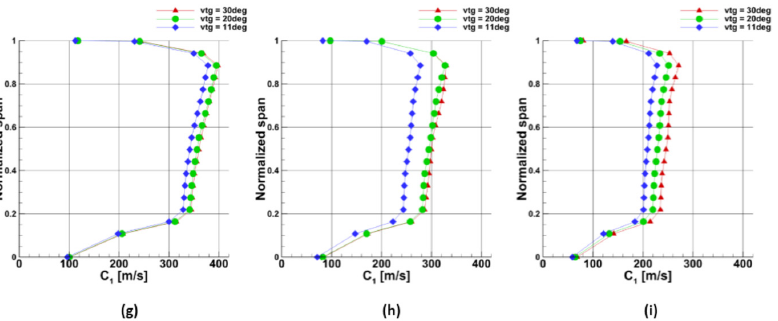
Figure 26. The plots of the absolute velocity C 1 measured behind the 1st stage nozzle vane against the blade height for: ( a – c ) 60,000 rpm point A, B, C respectively, ( d – f ) 50,000 rpm point A, B, C respectively, ( g – i ) 40,000 rpm point A, B, C respectively.